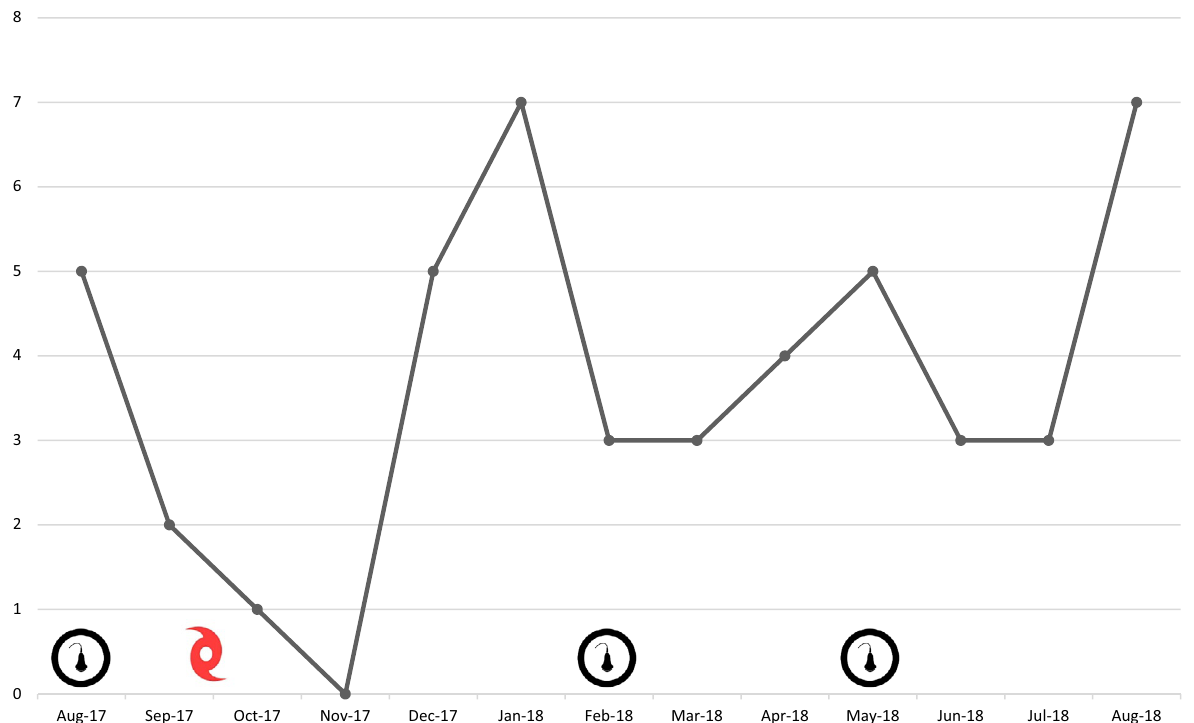
Fig. 4 The number of studies saved on the ultrasound machine over the 12‑month curriculum. The images of the ultrasound probe correspond to each of the three teaching sessions. The hurricane symbol corresponds to the timing of the two hurricanes that devastated the island